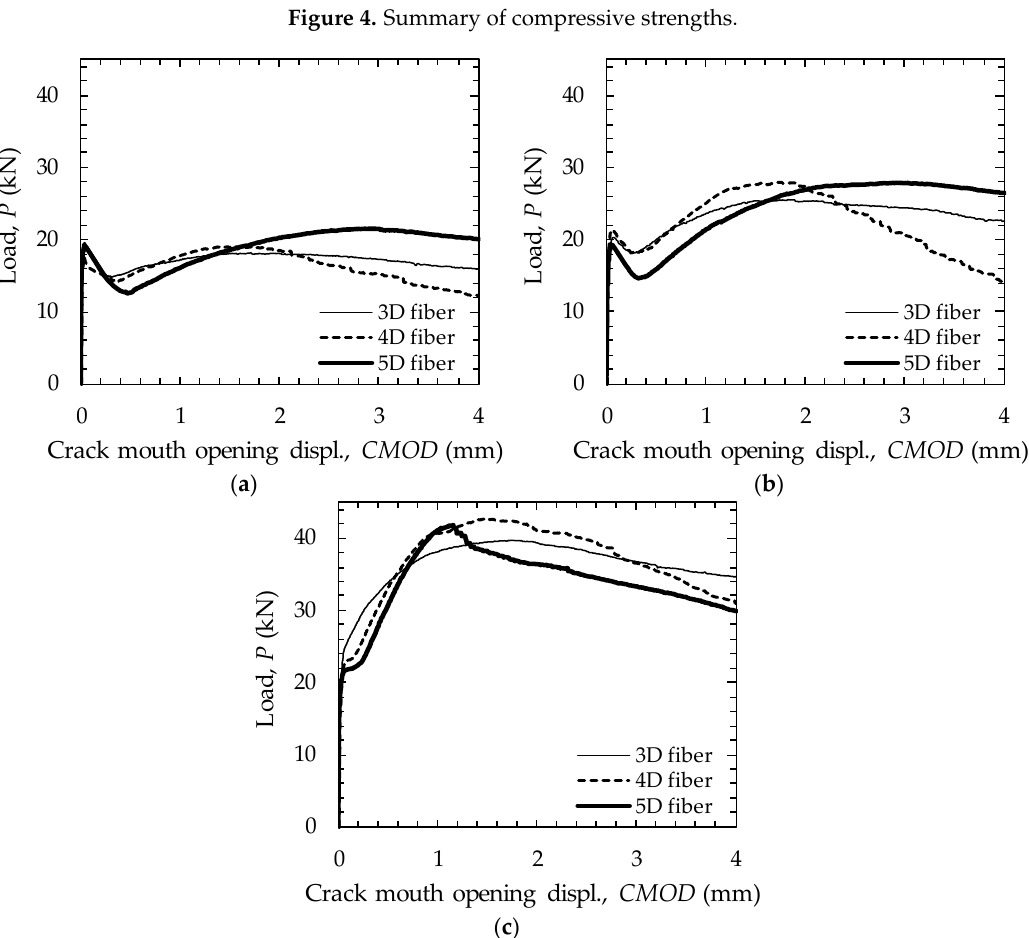
Figure 5. Summary of three-point flexural test results: ( a ) v f of 0.37%, ( b ) v f of 0.60%, and ( c ) v f of 1.00%.